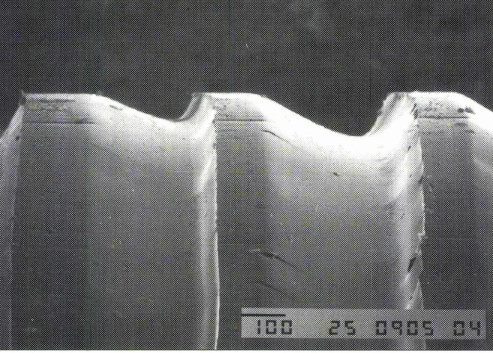
Fig. 2: Principle of direct